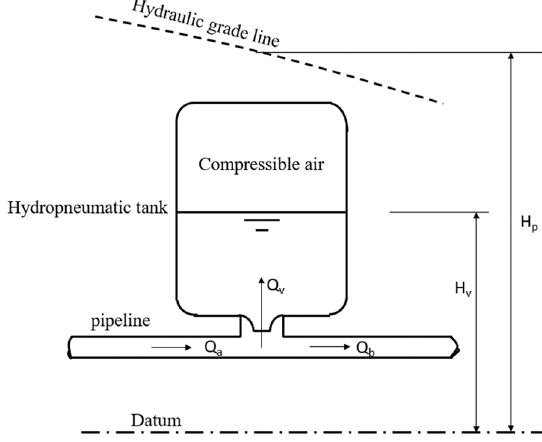
Fig. 1 Mathematical model of the hydropneumatic